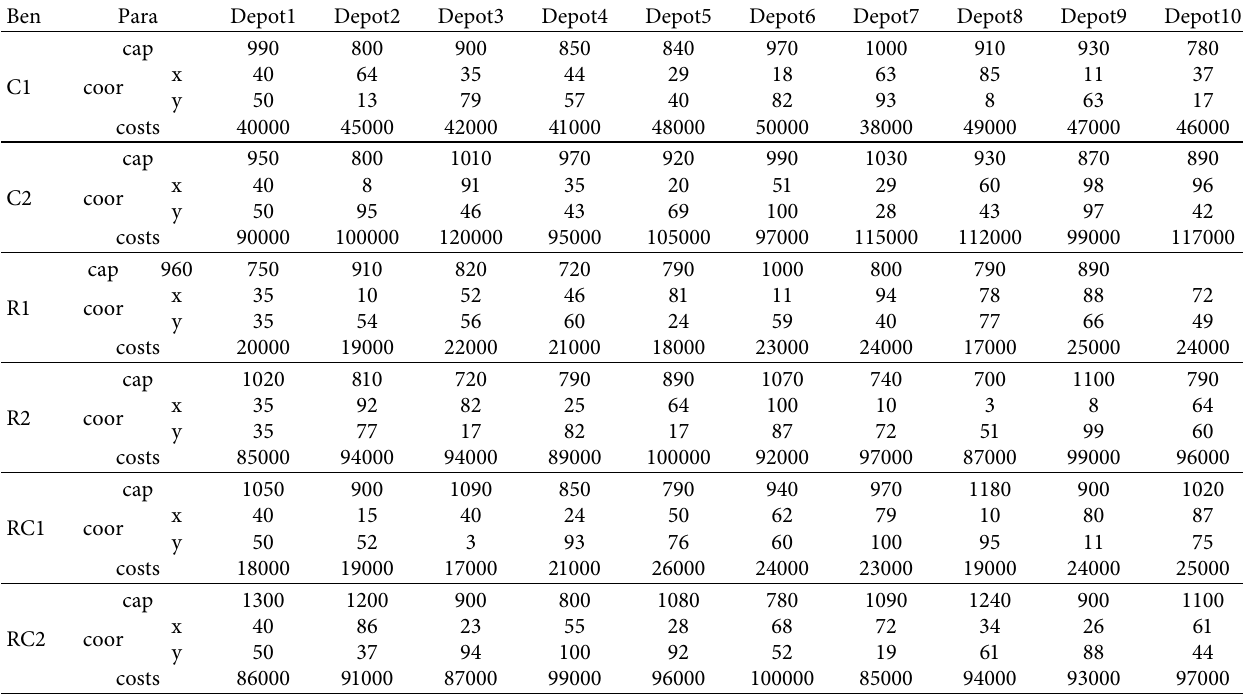
Table 4: Data of the depots.